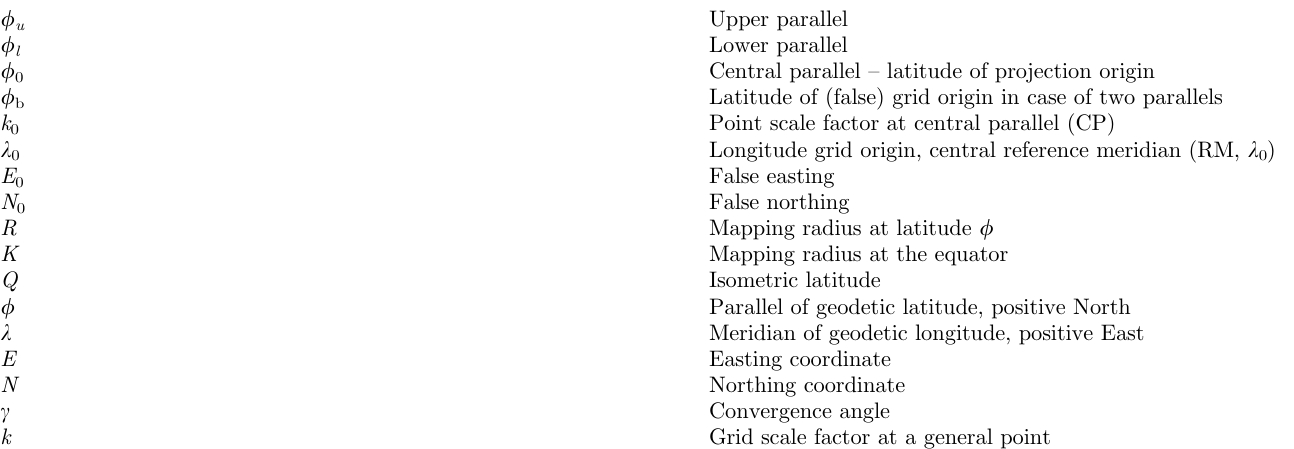
Table D-1. De fi nitions and symbols of